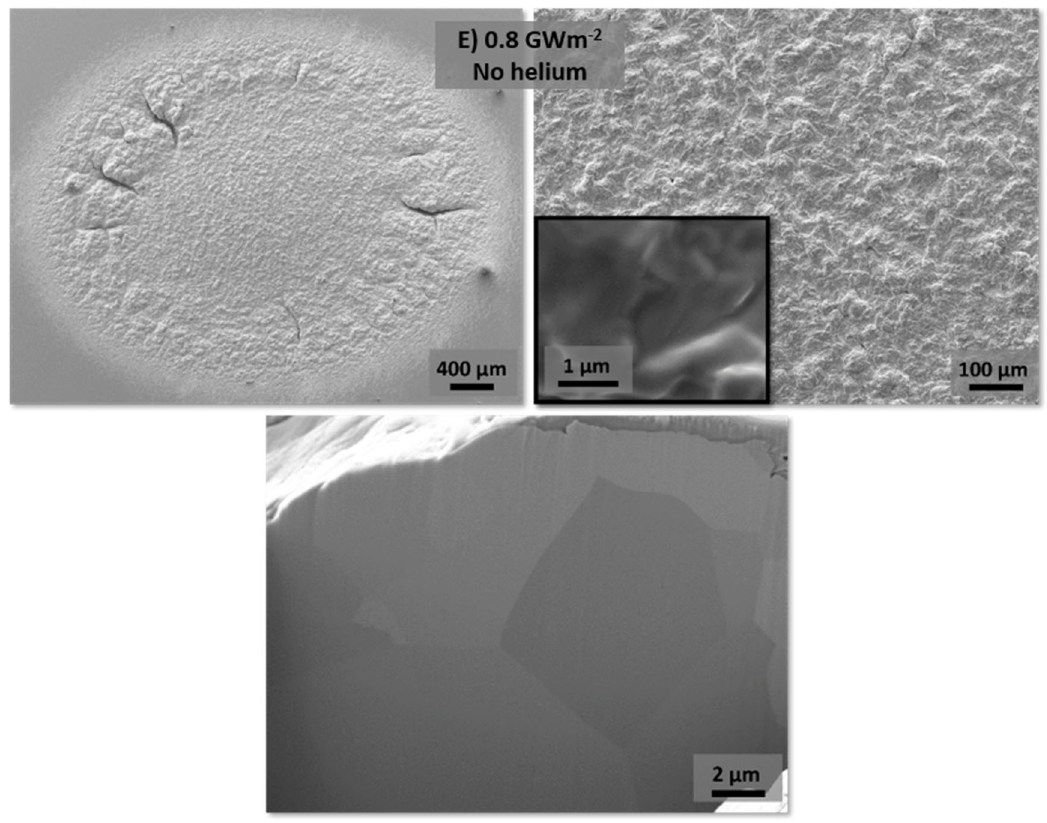
Figure 4. SEM images of the laser spot, close ‐ up and FIB cut of sample E, which was exposed to 10 5 − 2 and D laser pulses with a P abs of 0.8 GWm − 2 and D plasma. 10 5 laser pulses with a P abs of 0.8 GWm